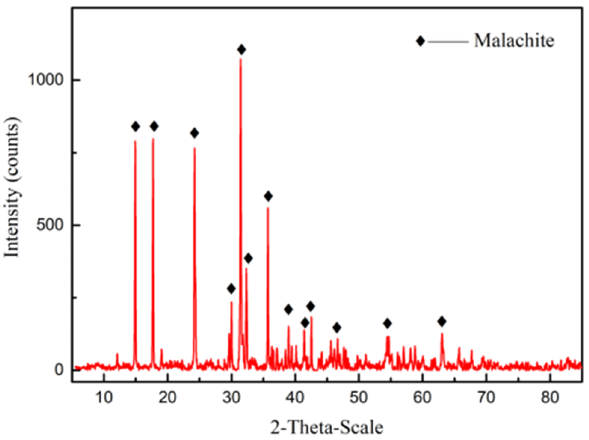
Figure 2. XRD pattern of malachite